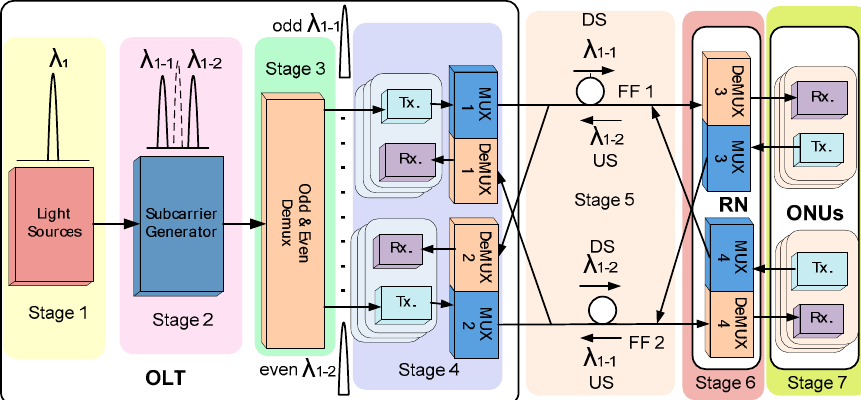
Figure 1. The proposed high capacity Dense Wavelength Division Multiplexing (DWDM-PON) system based on the modified cross seeding architecture; DeMUX: demultiplexer; Tx.: transmitter; Rx.: receiver; MUX: multiplexer; DS: downstream path; US: upstream path; FF1: feed fiber 1; FF2: feed fiber 2; RN: remote node; ONUs: optical network units.